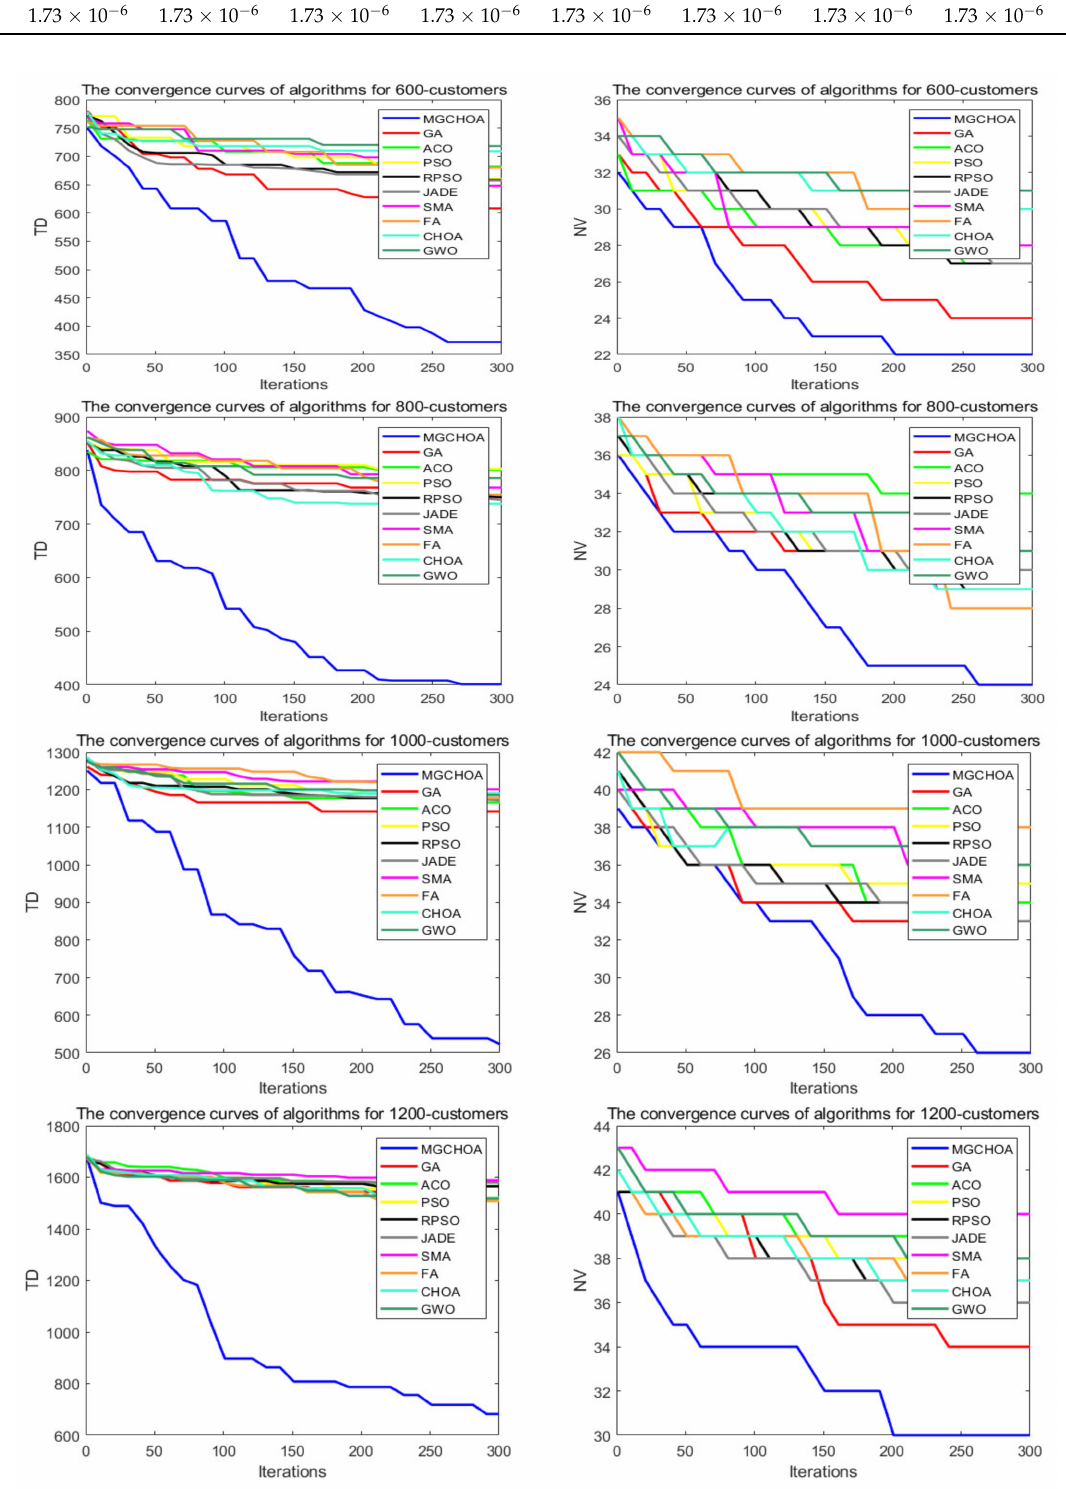
Figure 14. The convergence curves after 300 iterations of